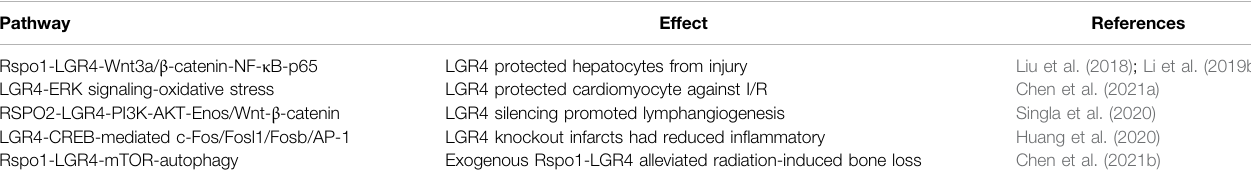
TABLE 4 | Increased impacts of LGR4 gene on oxidative stress